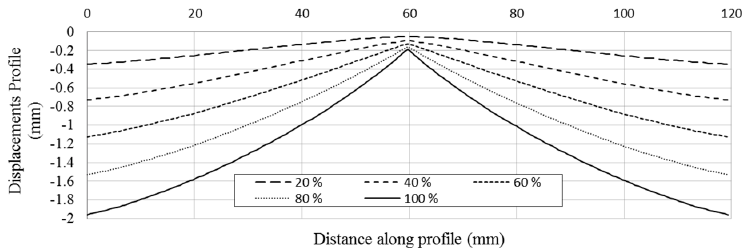
Figure 11. Evolution of the out of plane displacements along the profiles AA’ (defined in Figure 10a) at different displacement steps (in percentage) for a 3 mm-thick specimen, corresponding 100% to − 2 mm cylinder displacement.